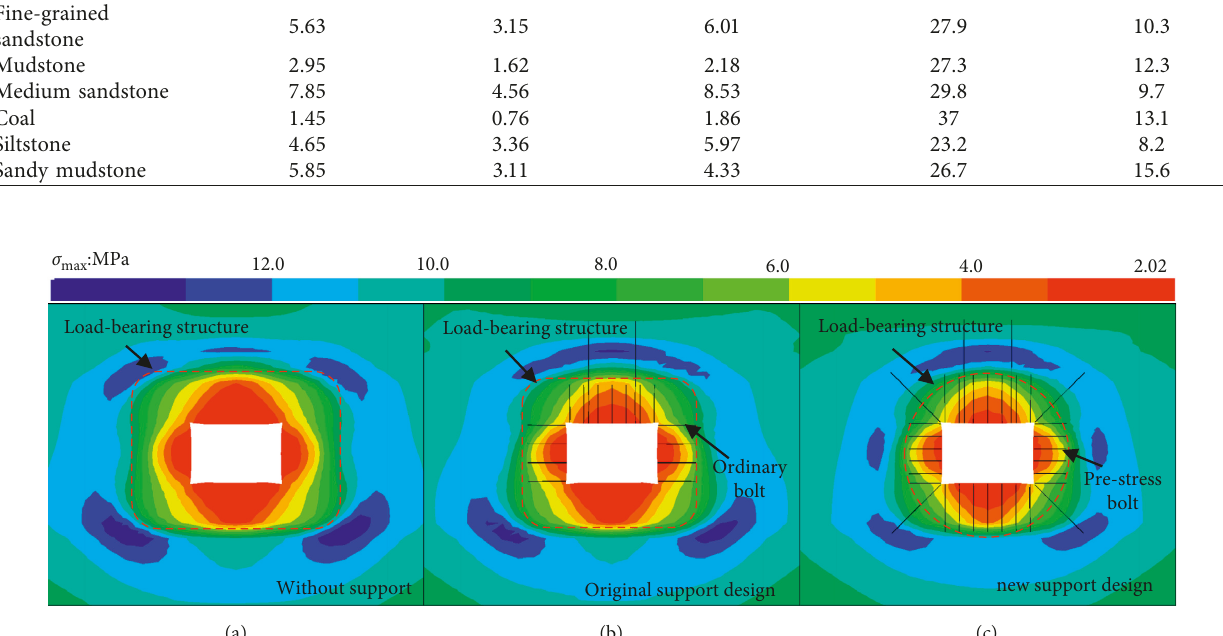
Table 2: Physicomechanical performance of coal seams and their surrounding rock mass.